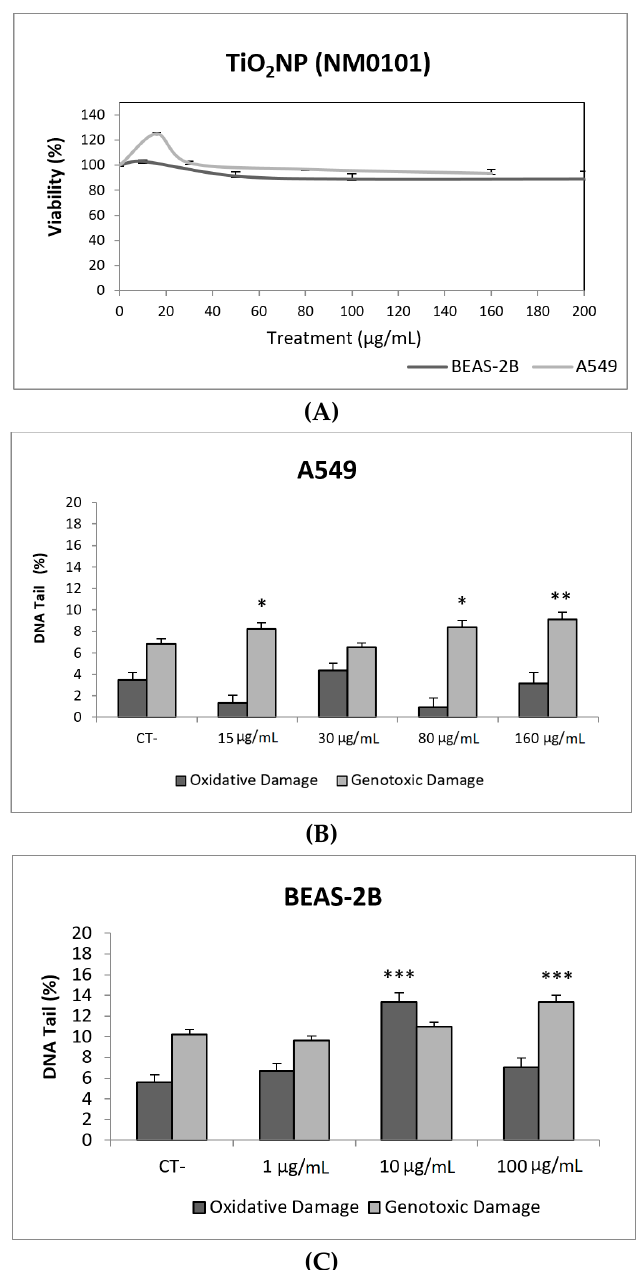
Figure 3. Results from the TiO 2 NPs (NM101) on A549 and BEAS-2B cells. ( A ) Toxicity curves for both cell lines. ( B ) Genotoxicity results obtained in A549 cells. ( C ) Genotoxicity results obtained in BEAS-2B cells. Genotoxicity data are plotted as mean ± SEM of two independent experiments. * p ≤ 0.05, ** p ≤ 0.01, *** p ≤ 0.001 (one way-ANOVA). CT, control.